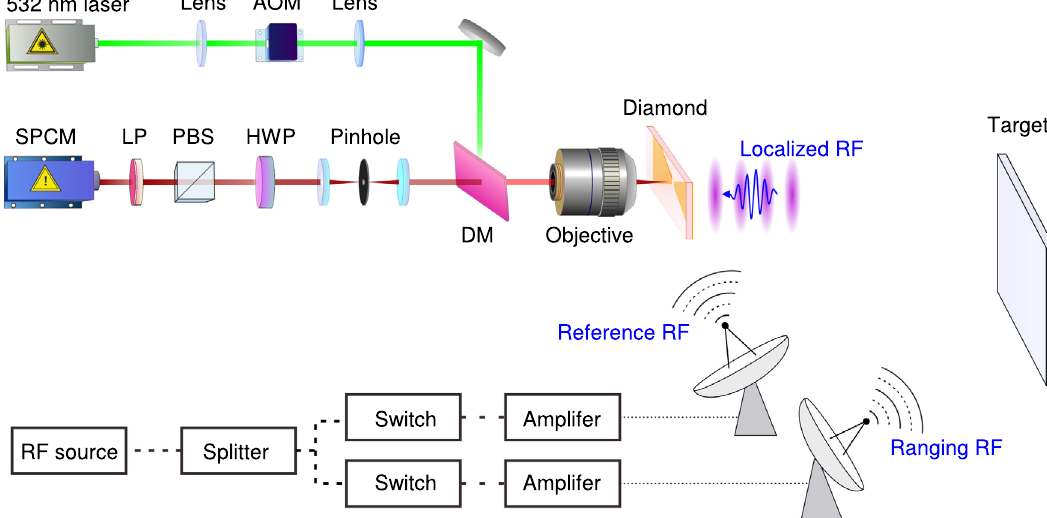
beam splitter, LP longpass fi lter with an edge wavelength of 633nm; HWP half- wave